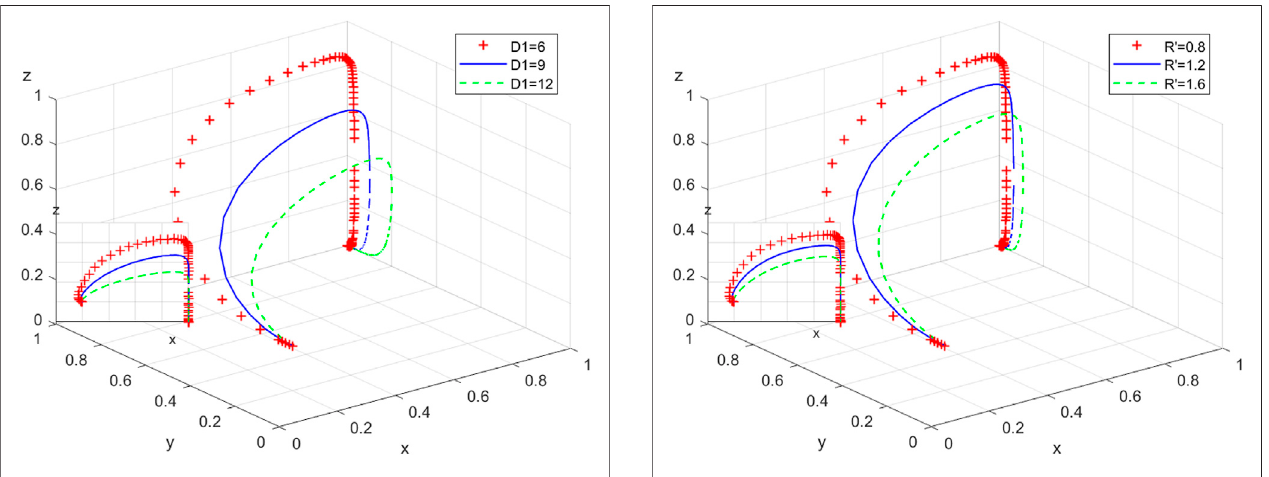
Frontiers in Environmental Science |